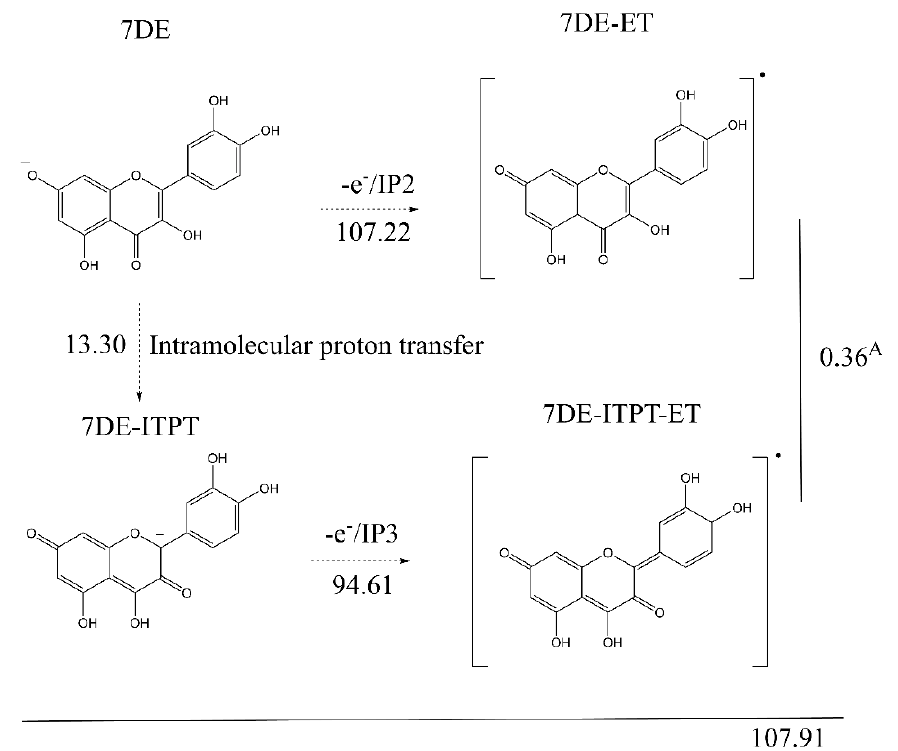
Figure 3. The two pathways for the electron transfer of 7-OH deprotonated Q (7DE) to a Q radical. The enthalpies requirement (Kcal/mol) of the reactions are given. The first pathway is a direct electron transfer from 7DE giving 7DE-ET. The second pathway is first an intramolecular proton transfer from 7DE to give 7DE-ITPT, followed by an electron transfer from 7DE-ITPT to give 7DE-ITPT-ET. The enthalpy difference of 0.36 Kcal/mol between the two conformers of the Q radicals, 7-DE-ET and 7DE-ITPT-ET, is also depicted.